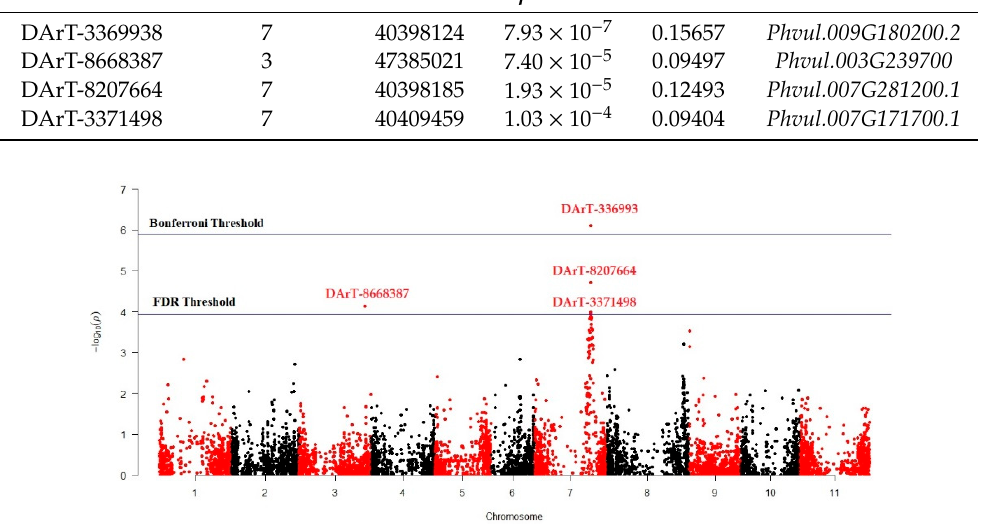
Figure 4. Manhattan plot reflecting marker trait association for antioxidant activity in common bean germplasm.